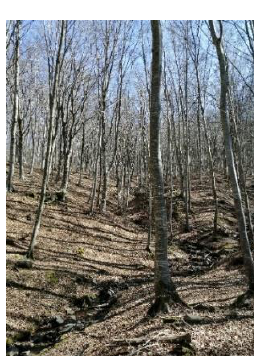
Figure 1.d Douglas fir forest, plot 8